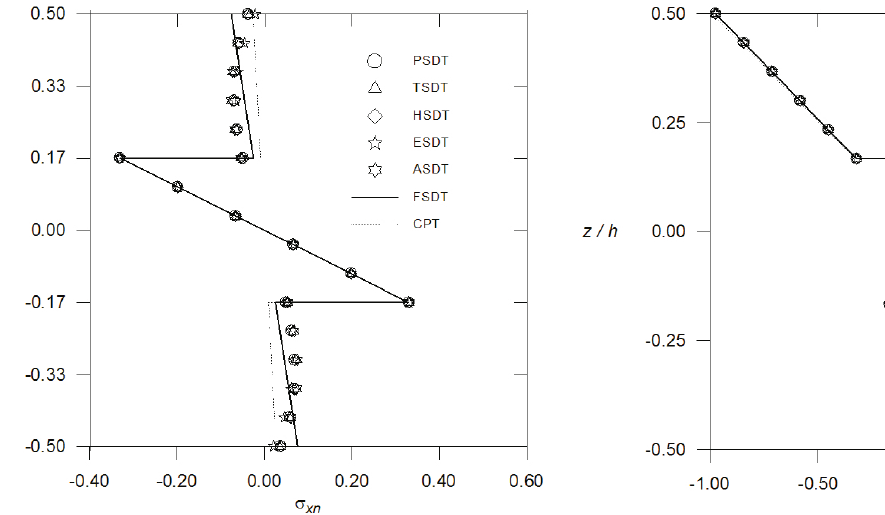
Figure 6: Variation of normalized in-plane normal stress σ x across the thickness for three layered (0 ∘ /90 ∘ /0 ∘ ) symmetric laminated composite square plate for aspect ratio 10.